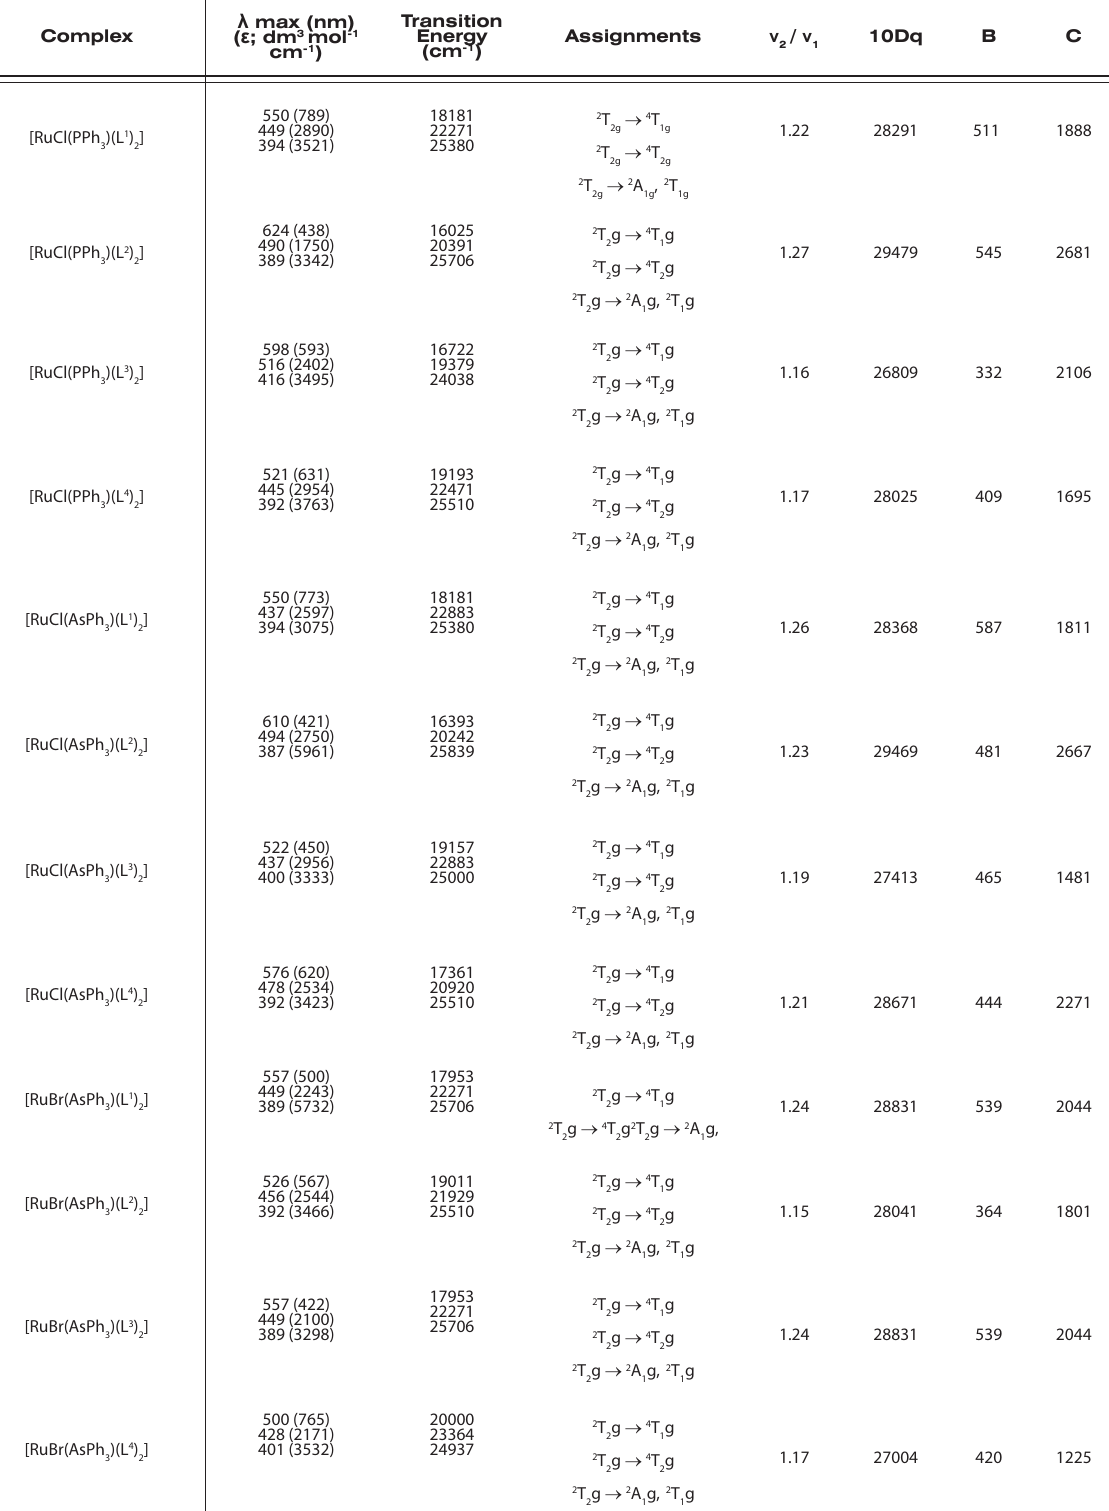
Table 2. Electronic spectroscopic data of the complexes